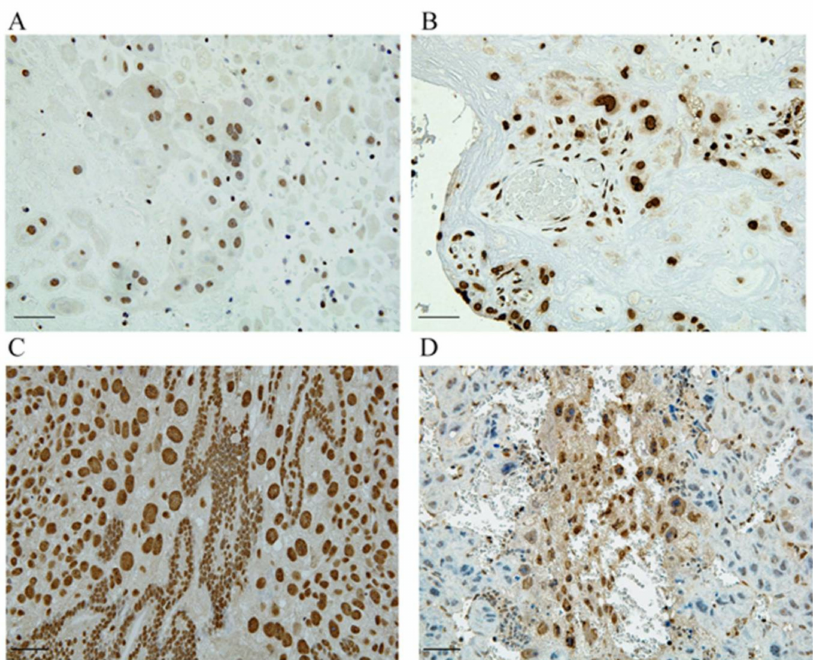
Figure 3. HMGA1 is expressed in the nuclei of trophoblasts. ( A , C ) HMGA1 is expressed only in the nuclei of EVTs derived from human normal placenta and at the implantation site of normal pregnant mouse. ( B , D ) HMGA1 in cytoplasm is observed in human PE placenta and HMGA1 is also extracellularly released from trophoblasts derived from our PE model. Scal bar = 100um. (This figure is quoted and modified from Ref